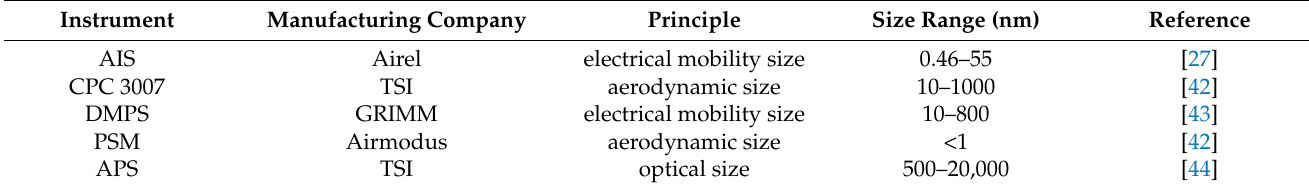
Table 1. Parameters of instrument for measuring